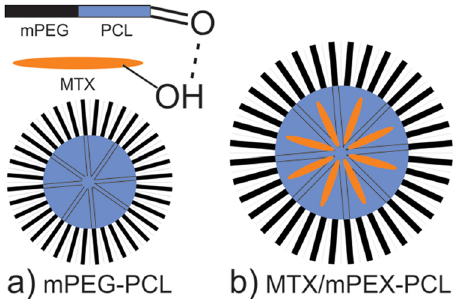
Figure 7: Schematic representation of ( a ) mPEG/PCL copolymer micelles and ( b ) methotrexate - loaded micelles ( MTX/mPEG - PCL ) . The interaction by hydrogen bonds between the OH groups of methotrexate and C = O of the hydrophobic block of the copolymer is